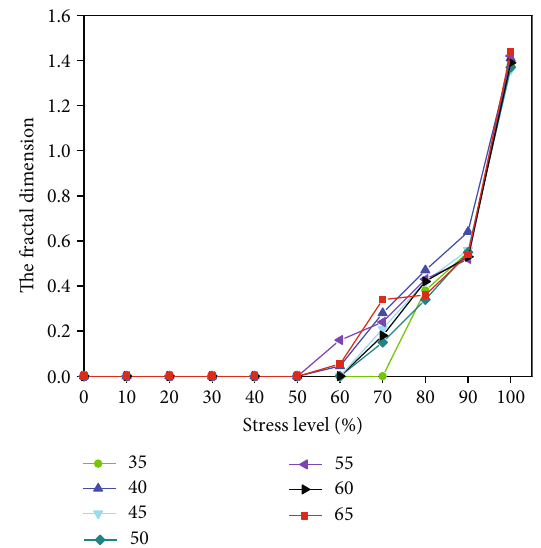
Figure 18: Relationship between the stress level and fractal dimension under di ff erent quartz contents.